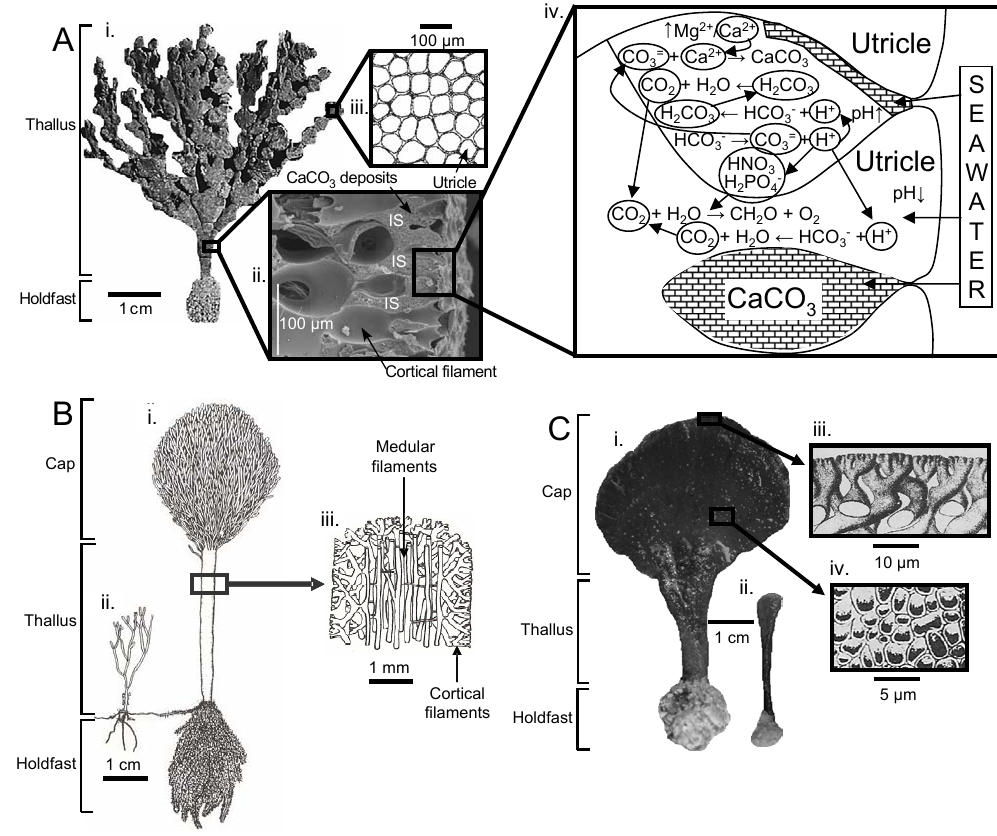
Fig. 2. Anatomy of the predominant CaCO 3 -producing bryopsidalean algae in modern carbonate platform environments. (A) Halimeda incrassata showing (i) the thallus, the calcified segments, and the uncalcified holdfast; (ii) an SEM image of a vertical section through the cortical layer of the thallus, showing extracellular calcification in the interutricular space (“IS”), external to the outer algal wall; (iii) corticated surface of a calcified segment resulting from coalescence of utricles; (iv) diagram showing the chemical connectivity between the primary mass-forming reactions (calcification, photosynthesis), the primary carbonate system equilibria, nutrient shuttling, localized Mg/Ca ratios, and pH within and between the coalescing utricles that form the calcified cortex of the Halimeda , Penicillus , and Udotea algae. (B) Penicillus capitatus showing (i) a full grown plant revealing uncalcified holdfast, calcified thallus and calcified cap; (ii) an offspring alga sprouting from rhizoids; and (iii) magnified diagram of thallus revealing the constituent calcified medullar and cortical filaments. (C) Udotea flabellum showing (i) full-grown alga revealing uncalcified holdfast, calcified thallus, and calcified fan; (ii) an offspring alga; (iii) vertical section through the cortical layer of the fan, showing coalescence of the utricles; and (iv) corticated surface of the fan (from Ries, 2005a, b, 2006a, 2009; after Fritsch, 1948, and B¨ohm et al.,